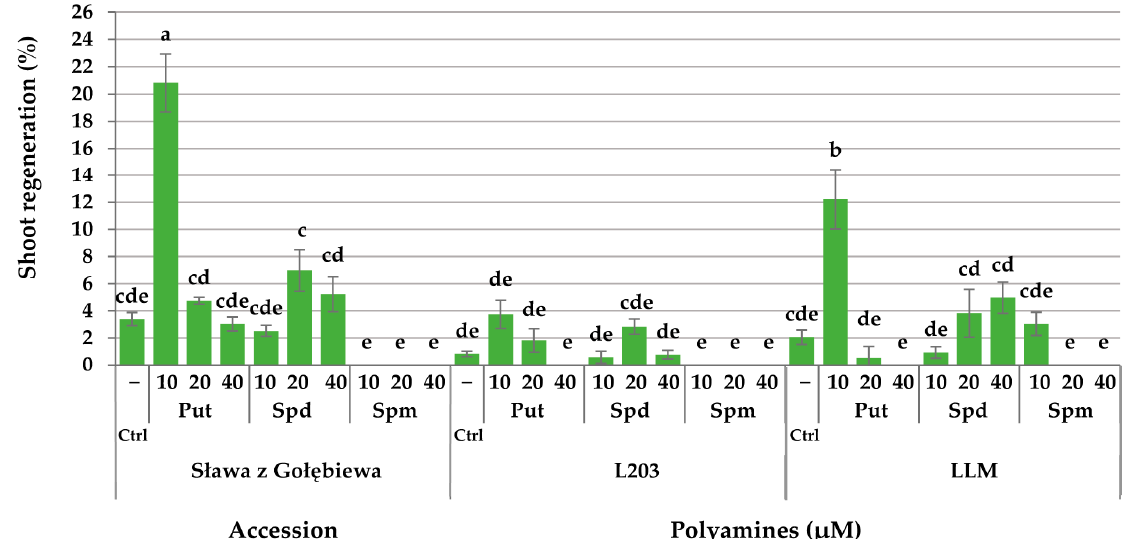
Figure 8. Interaction of the accession and exogenous putrescine (Put), spermidine (Spd), and spermine (Spm) on the shoot regeneration from protoplast-derived callus colonies of Brassica oleracea L. var. capitata. The bars represent the means ± SE ( n = 20). Values followed by the same letter were not significantly different ( p ≤ 0.05, HSD). Ctrl signifies the PA-free control media.